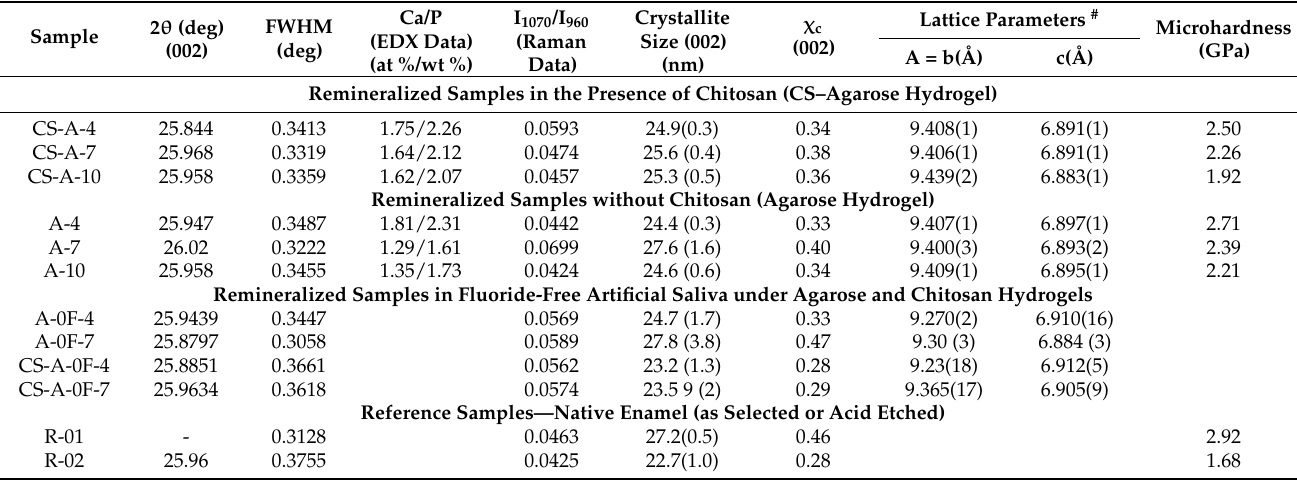
Table 1. Structural and compositional parameters of the remineralized enamel samples and the native (R-01) and acid-etched (R-02) enamel samples. Sample